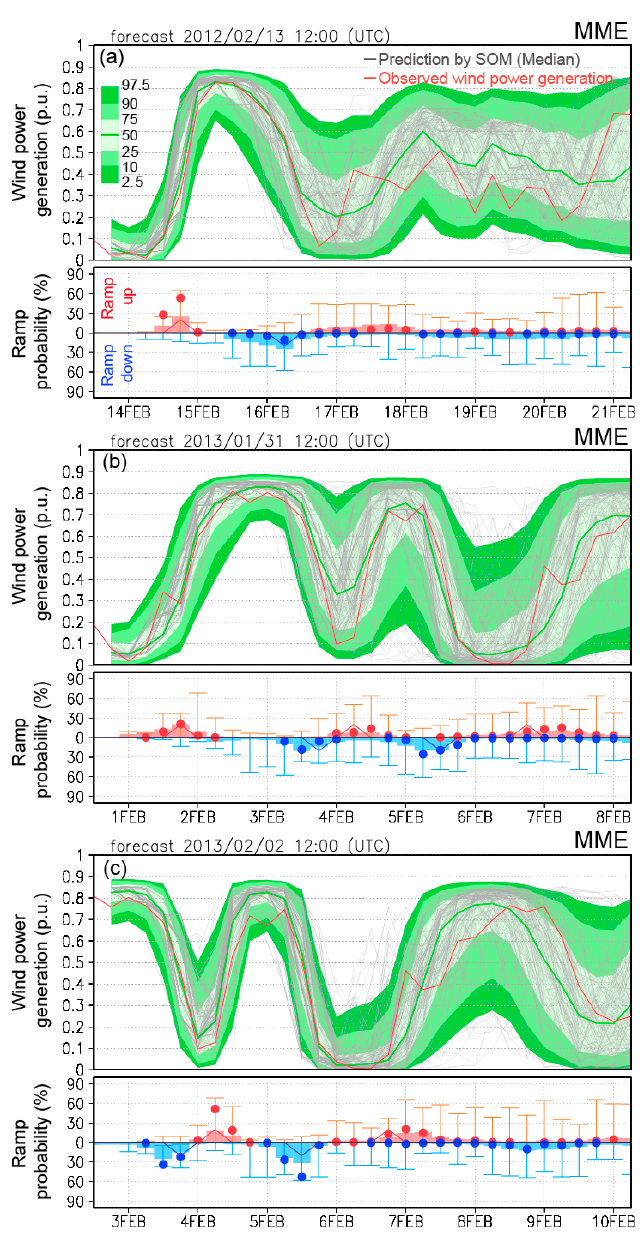
Figure 5. Forecasted 6-h wind power forecasts obtained from the single center ensembles with SOM-based analog-ensemble, initiated from ( a ) 13 February 2012, ( b ) 1 January 2013, and ( c ) 2 February 2013, at 12:00 UTC, as examples of the forecast results. The red line represents the observed wind power generation. PDFs of wind power generation obtained from the hybrid ensemble are represented by green shading. Gray line represents the median values of each ensemble member (total 168 lines). Each figure at the bottom shows the forecasted ramp probability obtained from the SOM nodes, and the medians of each ensemble are represented by red and blue bars and dots, respectively, with the error bar. Observed ramp-up and ramp-down events (actual state) are represented by the red and blue lines, respectively.